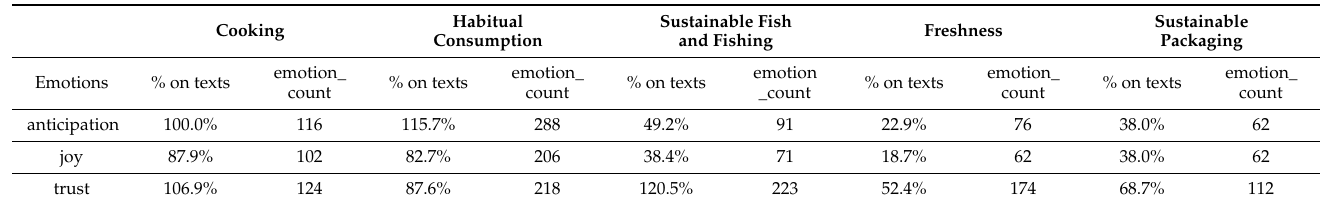
Table 4. Theme 1 Main emotion results with % value and absolute value_ALL